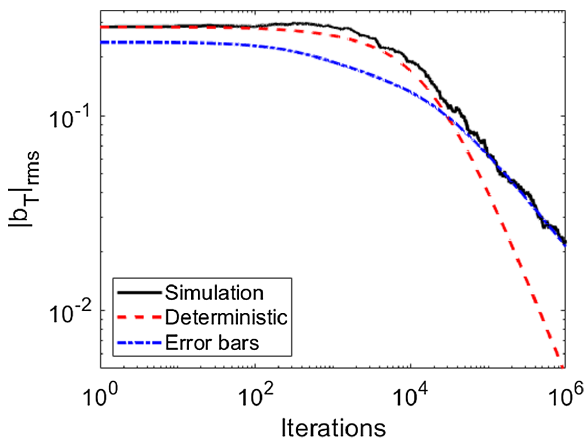
FIG. 9. The rms value of the discrepancy j b T j rms from a numerical simulation (solid black) and from iterating Eqs. (12) and (15) as well as the approximate error bars σ ð for a configuration with σ w increased to 0.3 mm and no